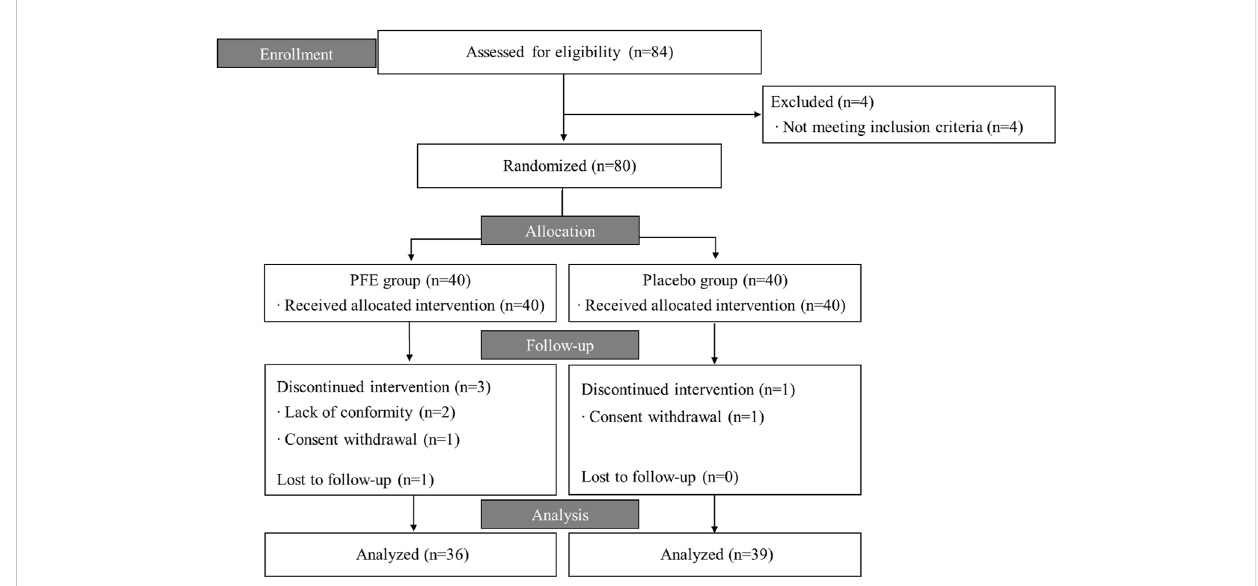
FIGURE 1 Flow chart of the trial process. PFE: Perilla frutescens (L.) Britton var. frutescens